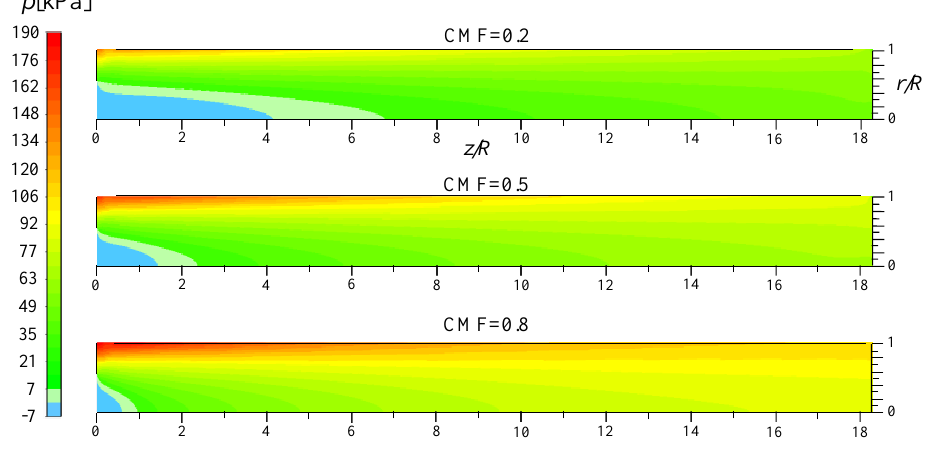
Figure 5. Pressure contours for different cold mass fractions.